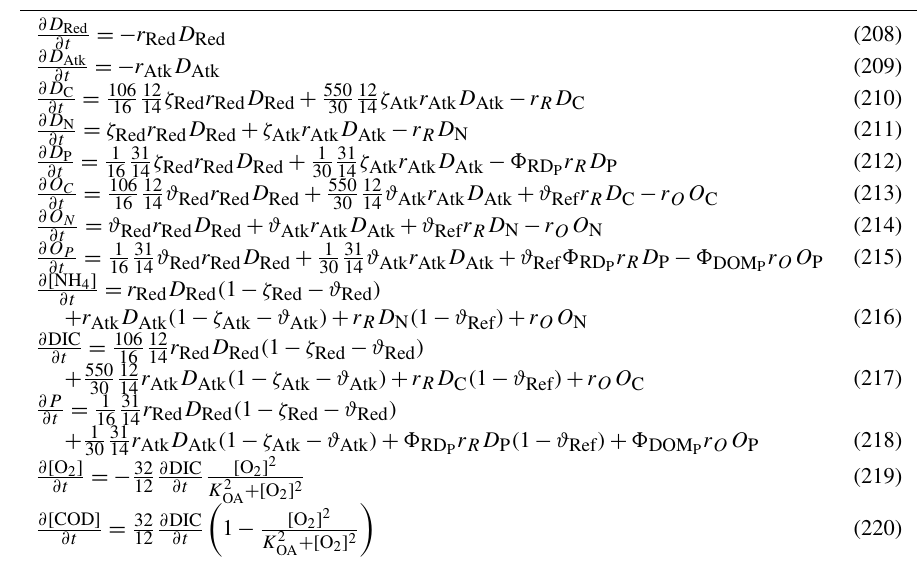
Table 38. Equations for detritus remineralisation in the water column and sediment.